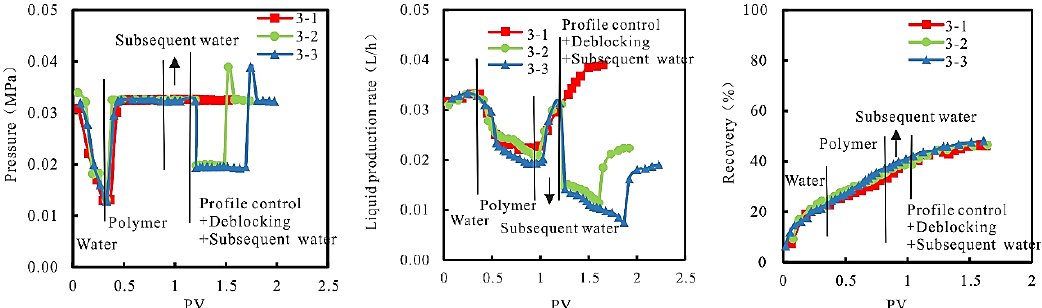
Figure 7. Relationships between injection pressure, production rate, and recovery, and PV.